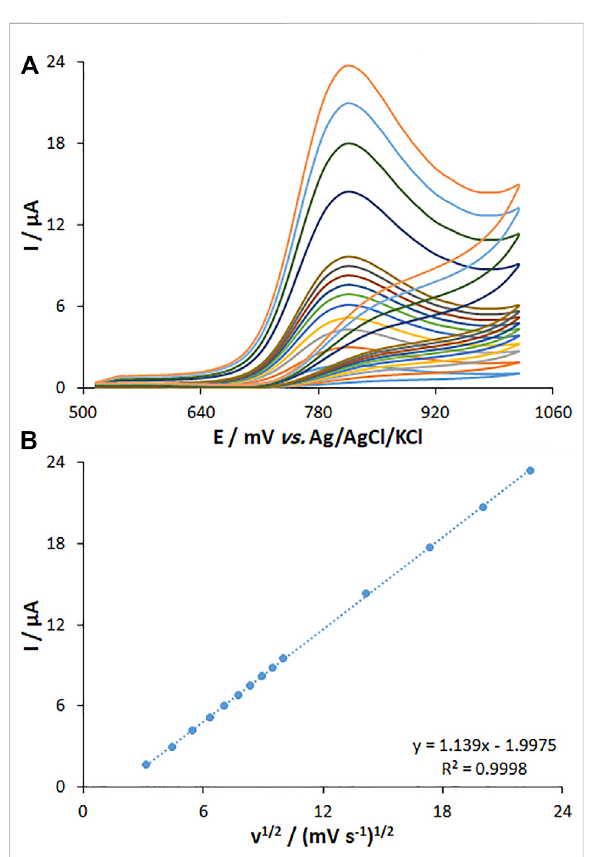
FIGURE 9 (A) CVs of MWCNT/HG-NiO-ND/PGE at pH 7.0 in the presence of fentanyl (20.0 µM) at various scan rates (from inner to outercurves):10,20,30,40,50,60,70,80,90,100,200,300,400, and 500 mV/s. (B) Plots of peak currents vs. υ 1/2